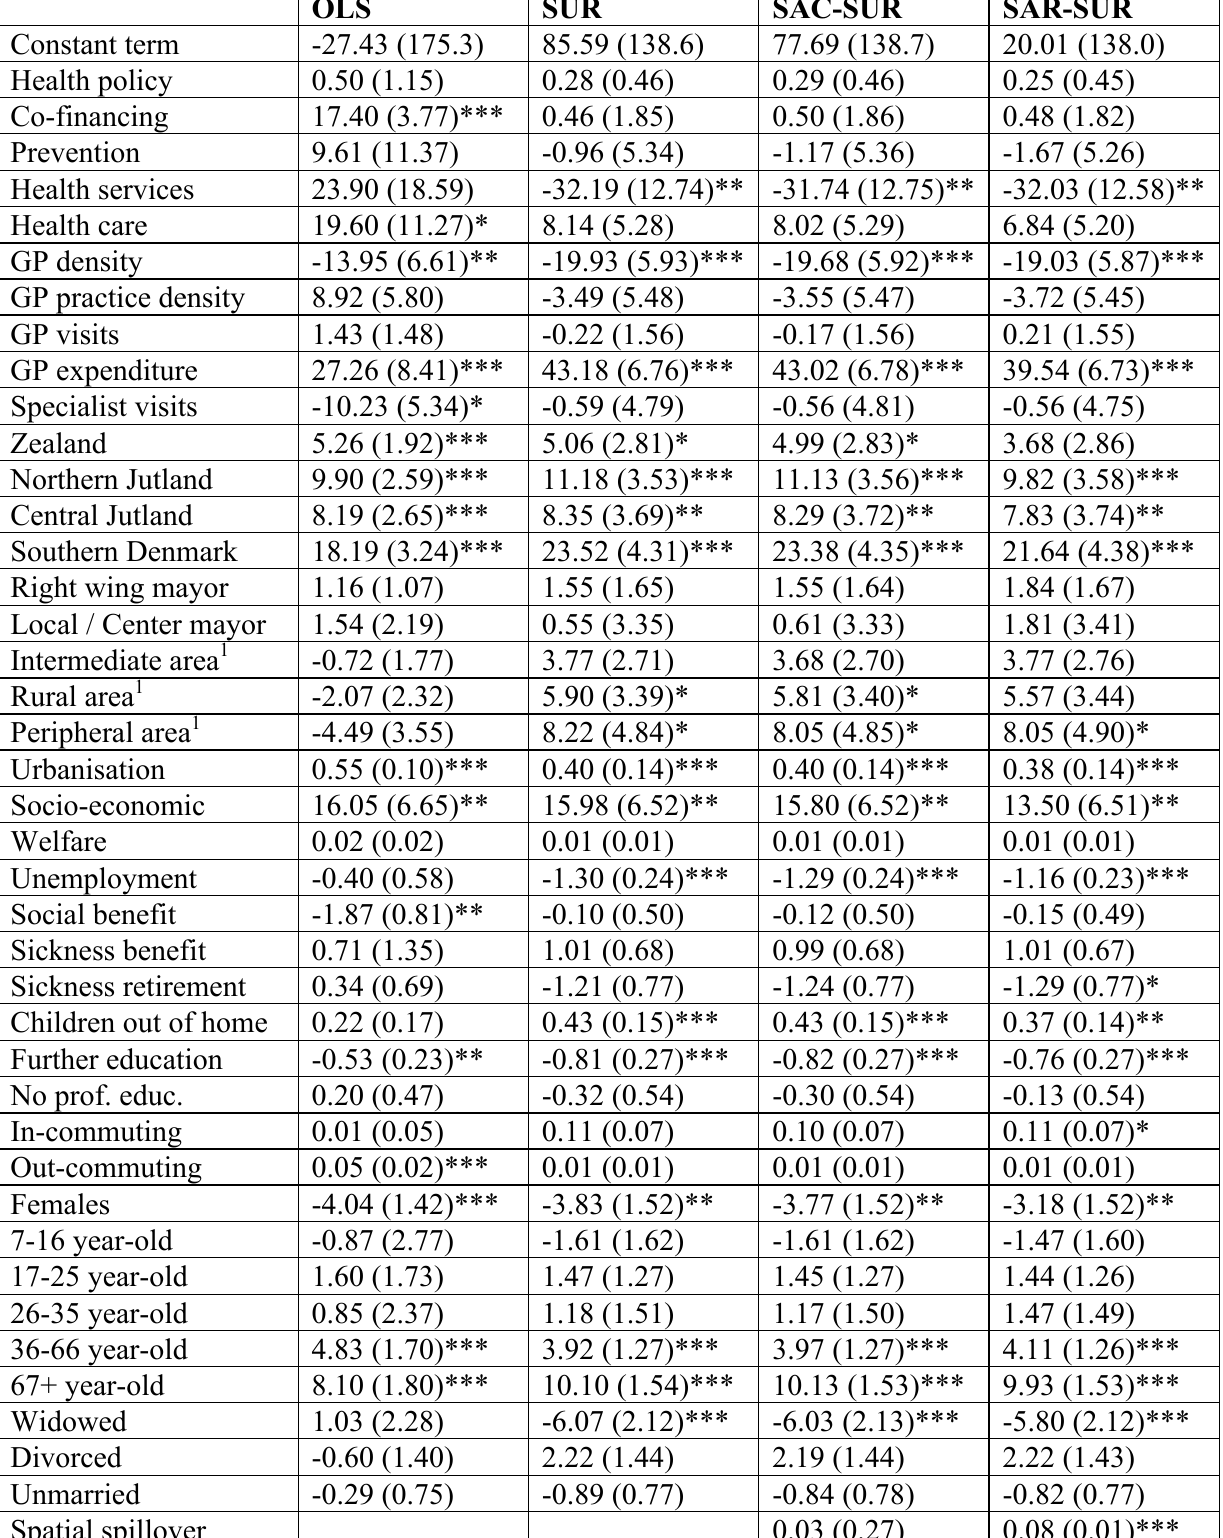
Table 3. Estimated specifications for cardiovascular